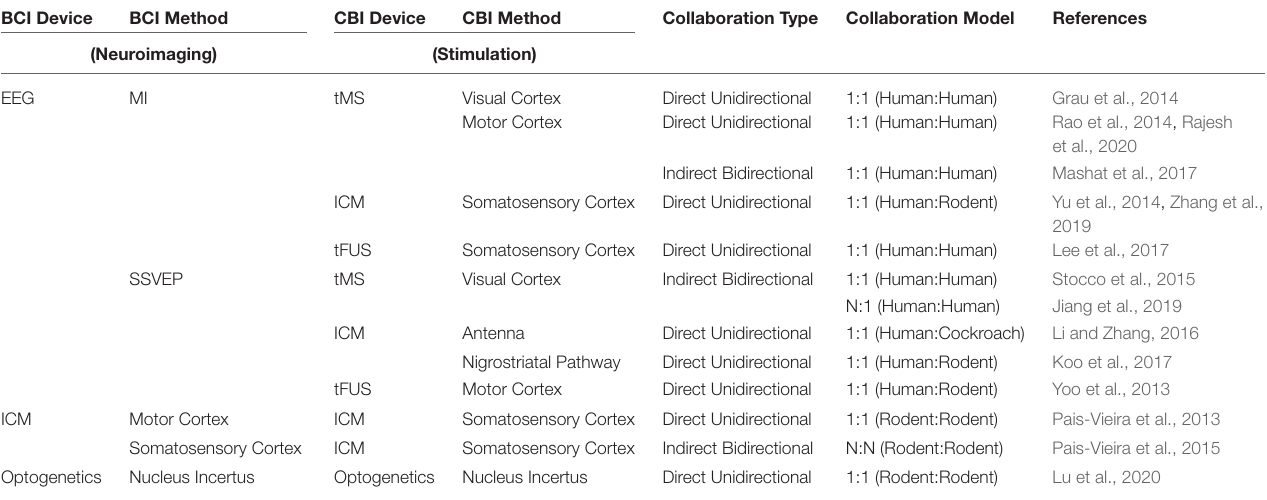
TABLE 1 | Summary of 15 brain-to-brain interfacing